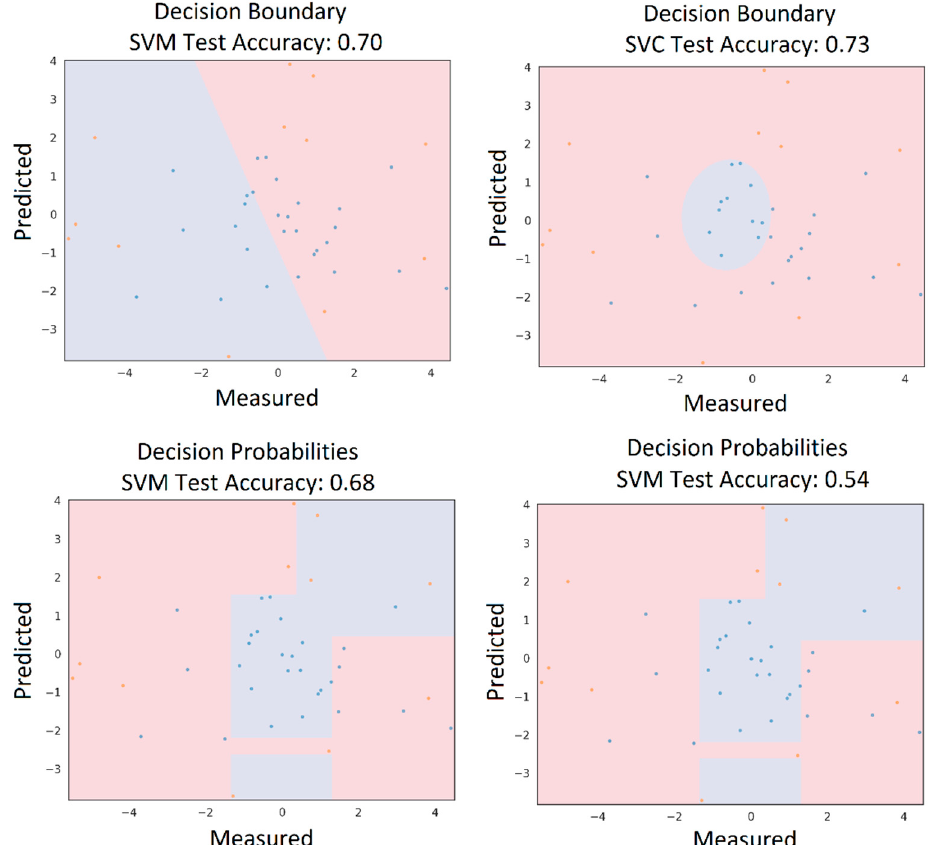
Figure 8. Demonstration of index values for the case of overprediction.